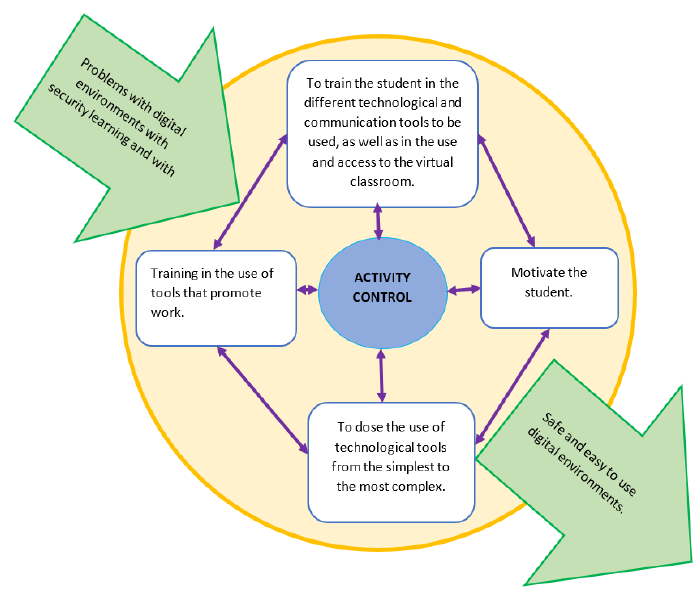
Fig. 14. Conceptual model applied to virtual